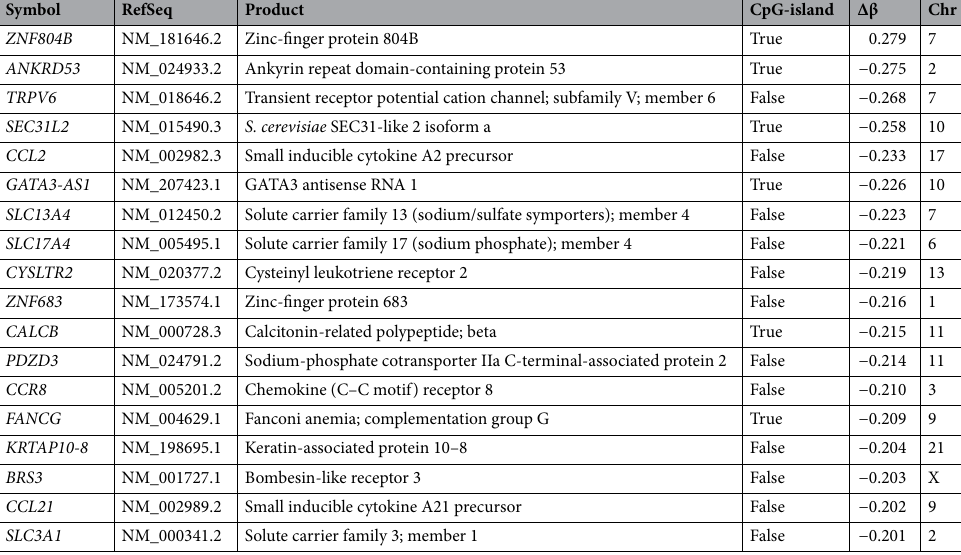
Table 1. Differentially methylated genes (FDR cutoff of p < 0.05 and Δβ > 0.2) in chorionic villi of miscarriages with trisomy 16.